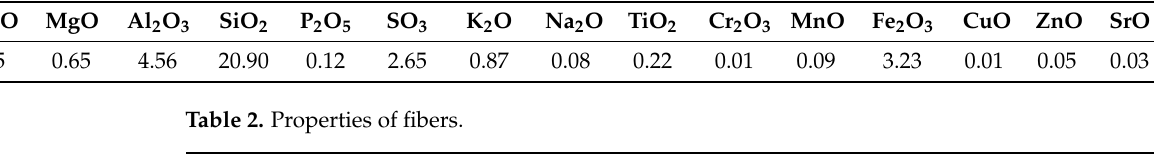
Table 1. Chemical components of cement (wt, %).